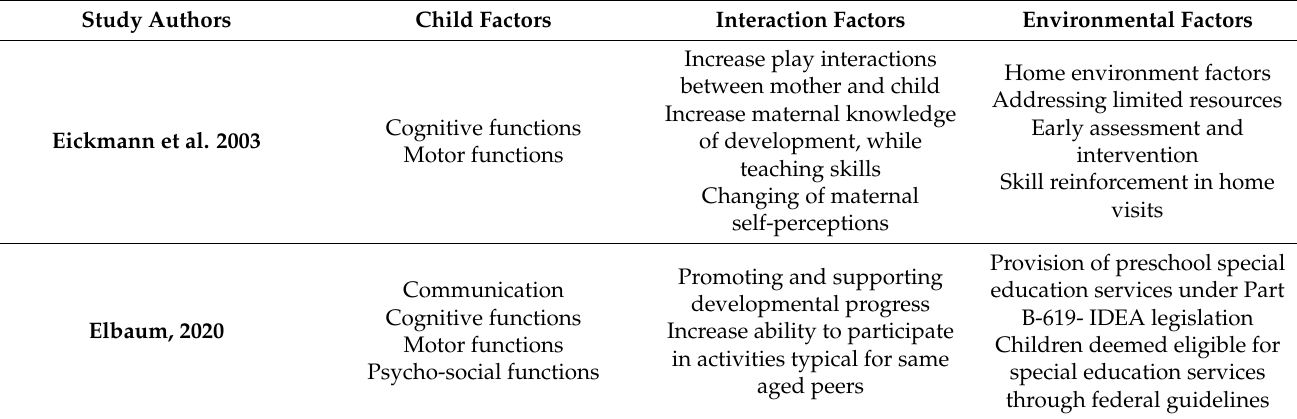
Table 1. Promoting early child development: a child-environment interaction framework. Study